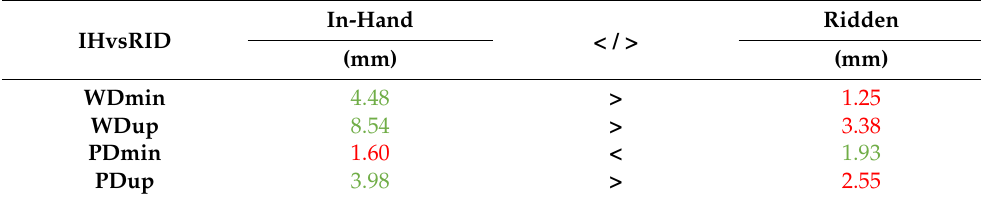
Table 3. Estimated marginal mean (EMM) values in mm for fixed factor IHvsRID (in-hand versus ridden exercise) for the four affected asymmetry parameters (see Table 2). All values in mm. The higher value for each asymmetry parameter is given in green, the lower value in red. Column ‘</>’ indicates whether the asymmetry for in-hand exercise is larger (‘>’) than for ridden exercise or smaller